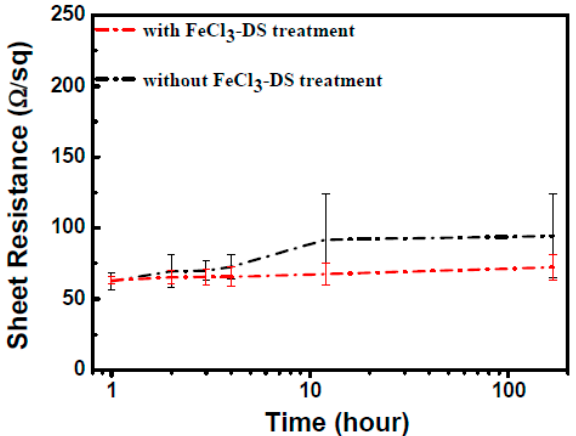
Figure 4. Sheet resistance variation of AgNW TCFs during gaseous chemical etching of H 2 S for pristine AgNW TCFs (black line) and FeCl 3 -DS treated ones (red